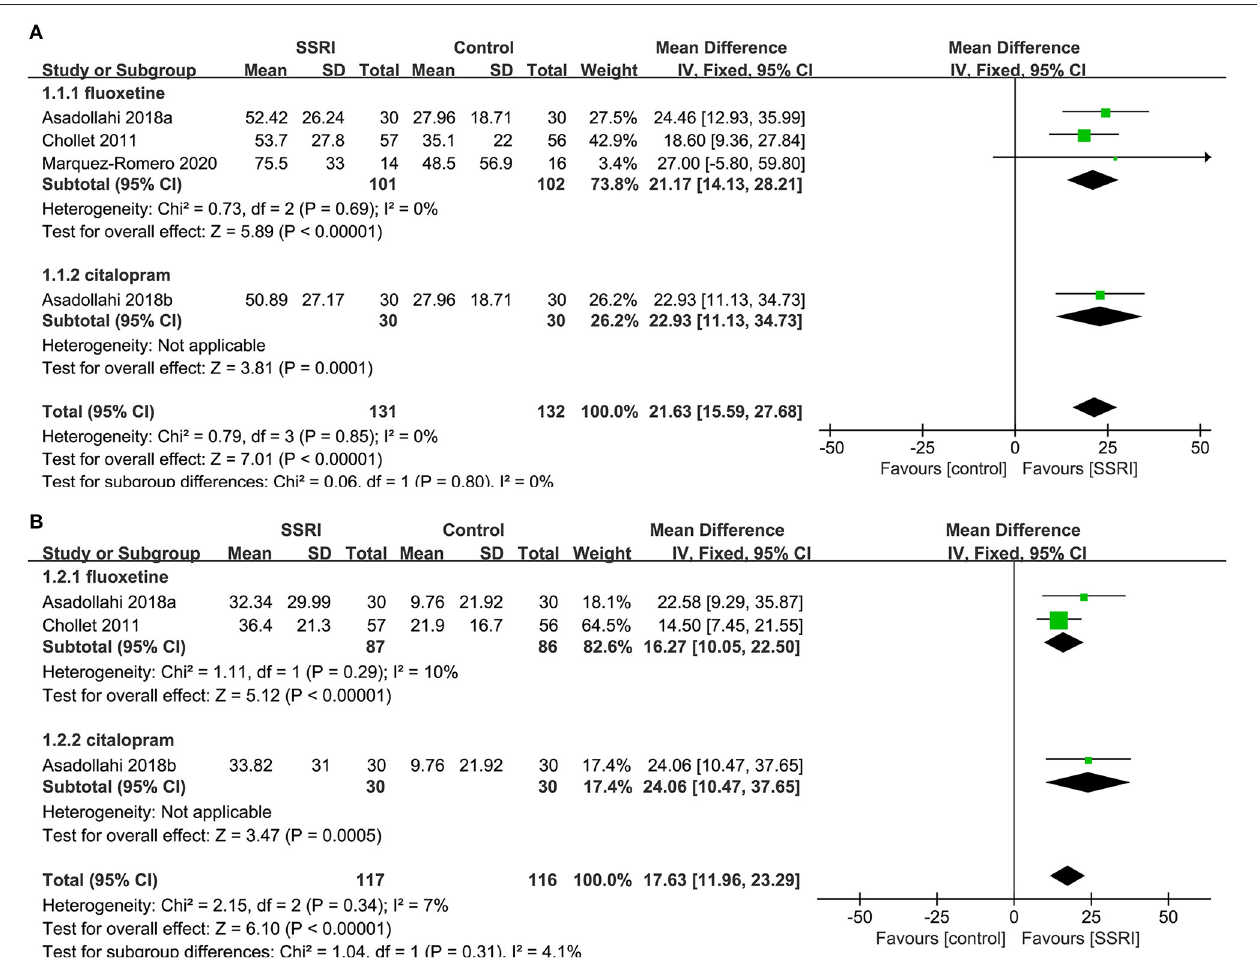
FIGURE 3 | Forest plot of primary efficacy outcomes. (A) FMMS-endpoint score, (B) FMMS-mean change. FMMS, Fugl-Meyer Motor Scale.